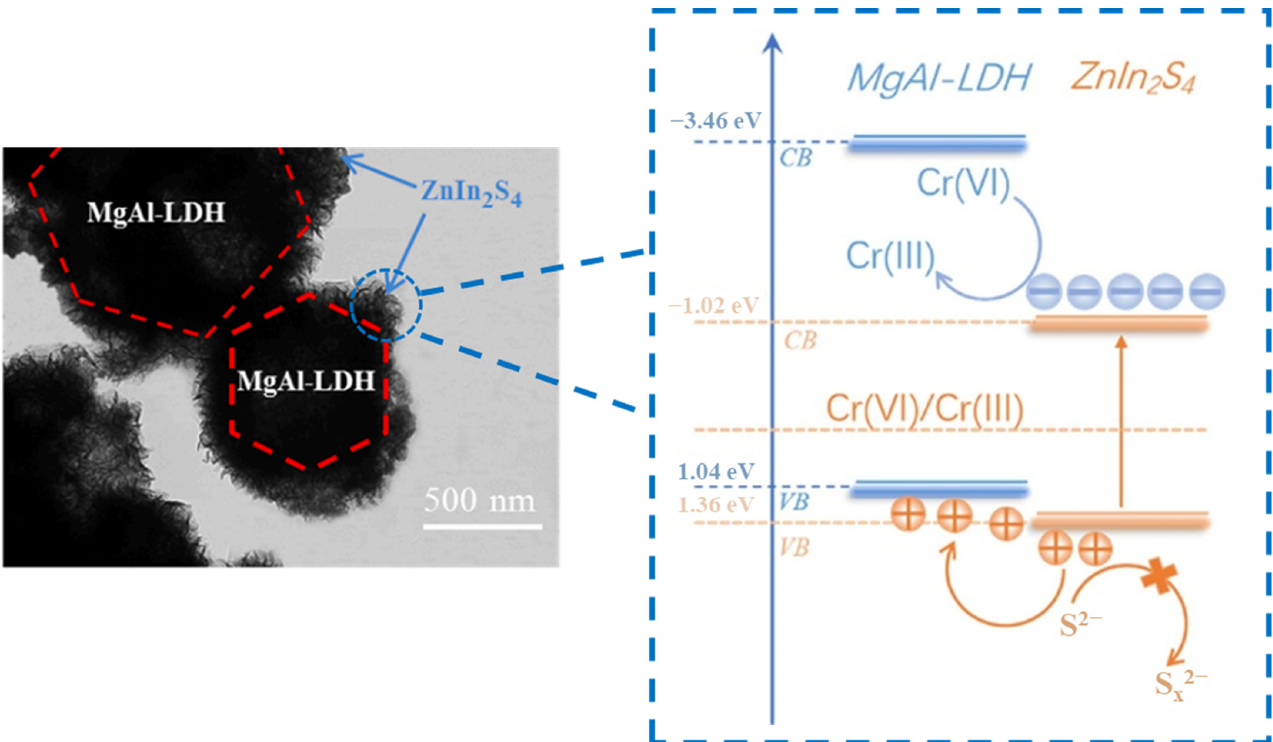
Figure 16. Mechanism schematic diagram of improving catalytic efficiency for ZnIn 2 S 4 /MgAl-LDH heterojunction [122].